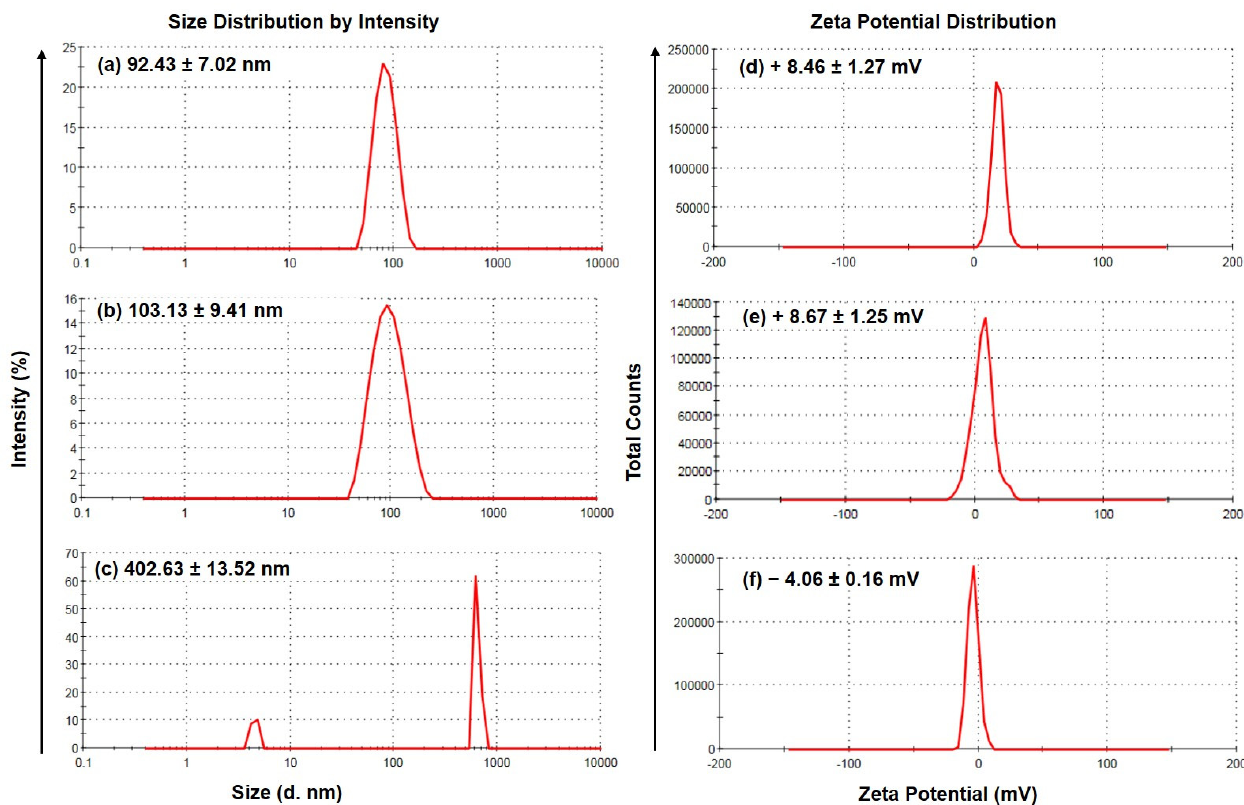
Figure 1. Size and zeta potential distributions of OLA-NCs-2 ( a , d ), respectively; OLA-NCs-2 with mannitol ( b , e ), respectively, and OLA-aqueous suspension ( c , f ), respectively. Data are expressed as mean of three measurements with standard deviation (Mean ± SD, n = 3). Table 2. Changes in the characteristics of OLA-NCs-2 after freeze-drying. Data are represented as mean of three measurements with standard deviation (Mean ± SD, n = 3).